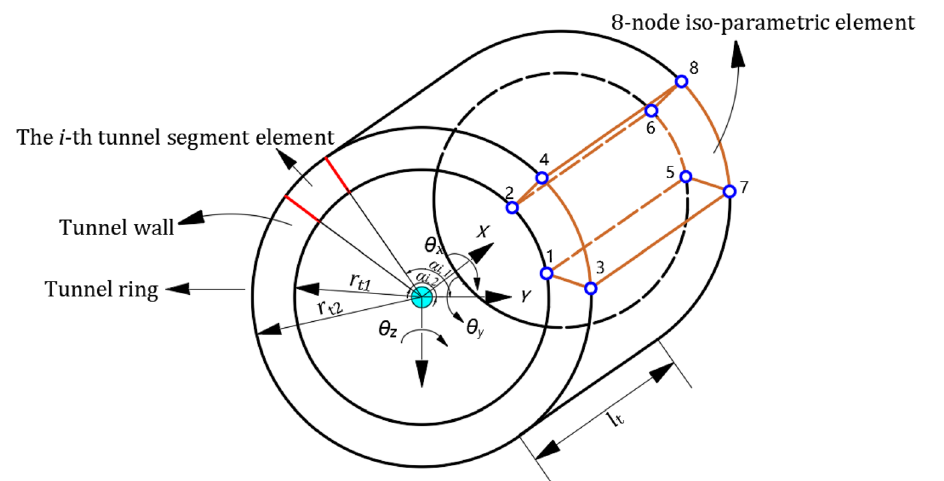
Fig. 2 Element for modelling the tunnel